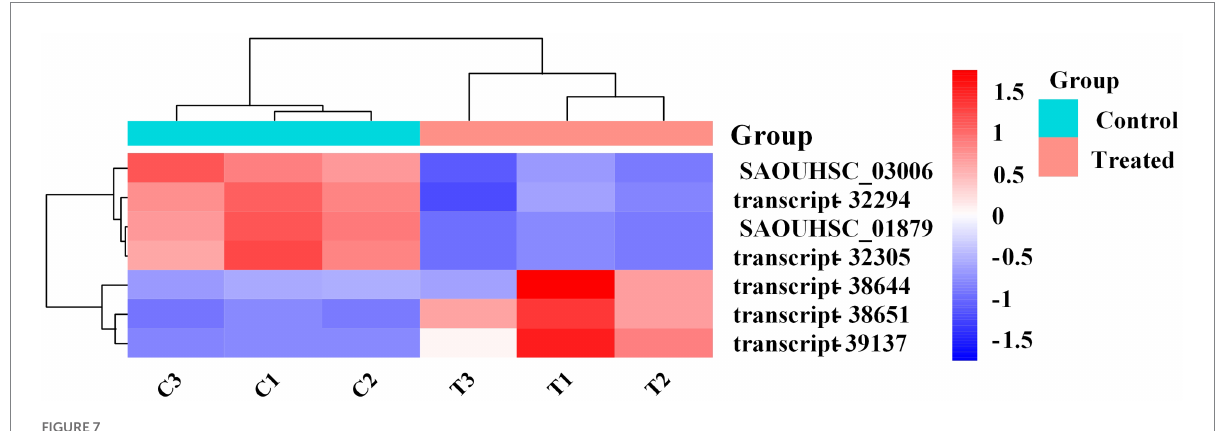
FIGURE 7 Validation of RNA-Seq expression for selected genes by